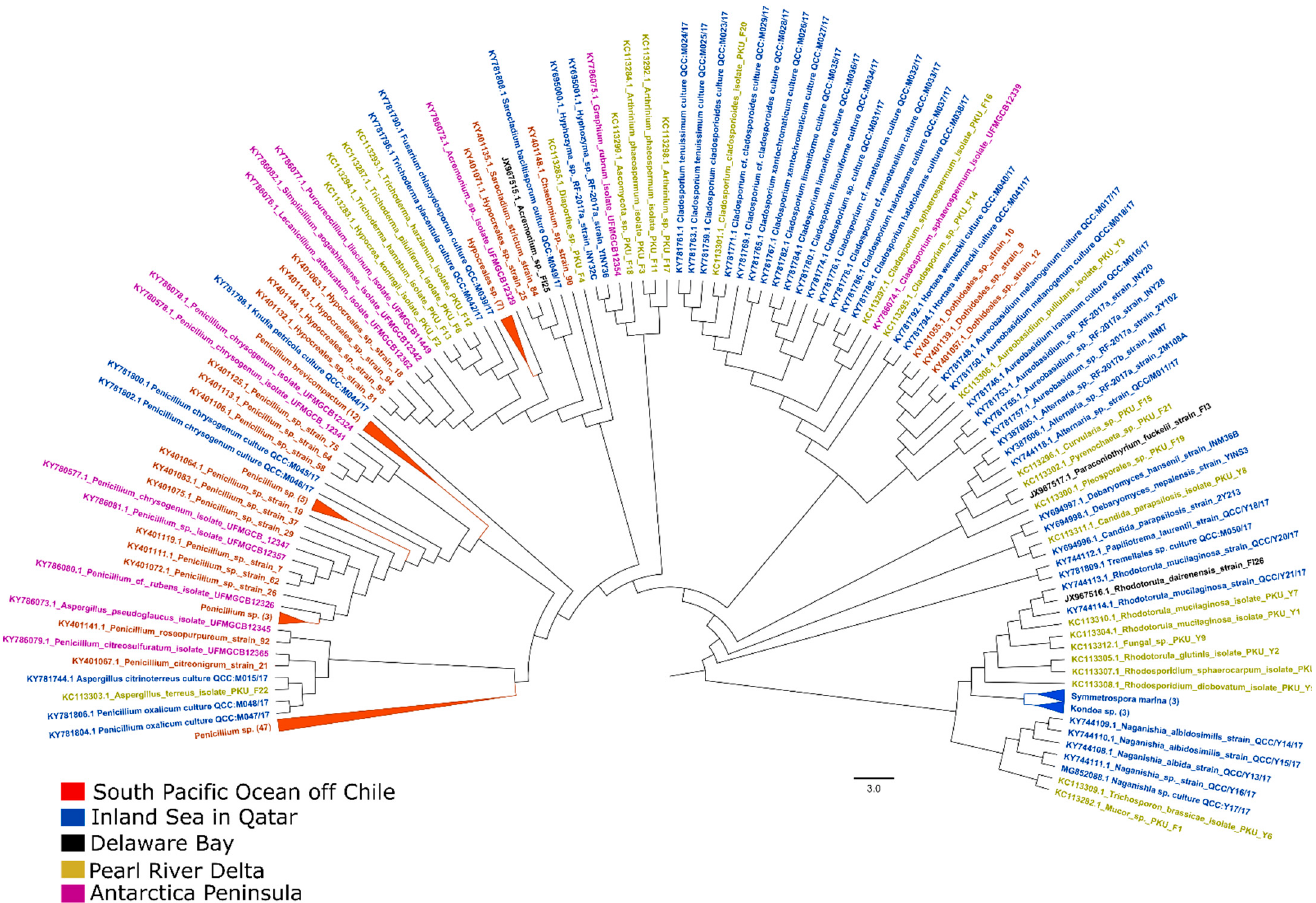
Figure 1. Maximum-likelihood (ML) tree of culturable fungi isolated from representative marine waters. A total of 192 ITS sequences of culturable fungi isolated from the water column (coastal and pelagic) across the globe were retrieved from the NCBI Nucleotide database. Sequences in the tree were aligned with MUSCLE using default settings. Phylogenetic analysis was performed using FastTree2.1 software (version 2.1, developed by Morgan N. Price, Berkeley, CA, USA) for the construction of the ML tree, which used the Shimodaira–Hasegawa test to estimate the reliability of each split in the tree. The sampling coordinates of the South Pacific Ocean off Chile [48], Inland Sea in Qatar [52], Delaware Bay [51], Pearl River Delta [49], and Antarctica Peninsula [50] are available in the corresponding publications.